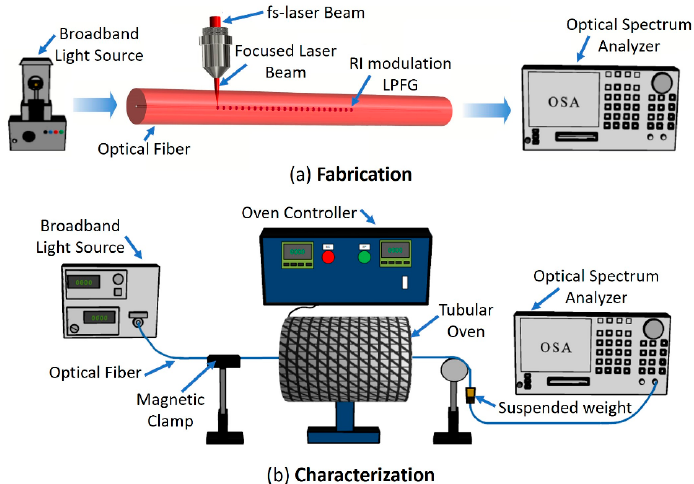
Figure 2. Schematic illustration of the long period fiber gratings (LPFGs): ( a ) fabrication, and ( b ) characterization procedures.